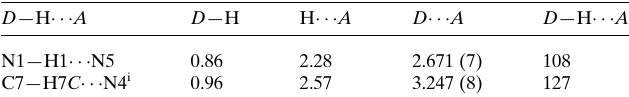
Table 1 Hydrogen-bond geometry (A˚ , (cid:2) ).